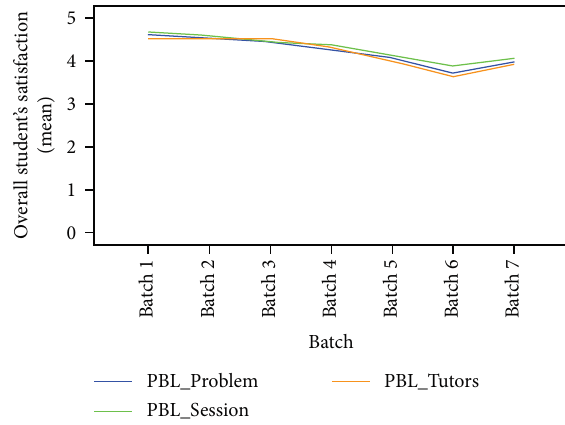
F IGURE 2: Overall student ’ s satisfaction on different factors of the PBLs from different